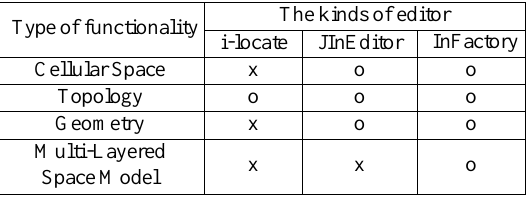
Table 1. The comparison between IndoorGML editing